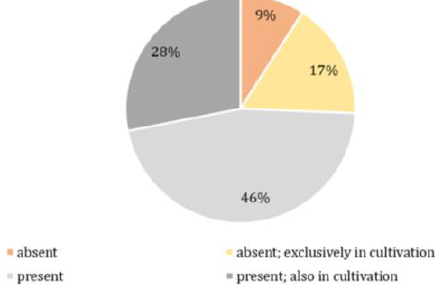
Fig. 1. Participation of invasive alien plant species in terms of occurrence in the natural environment in